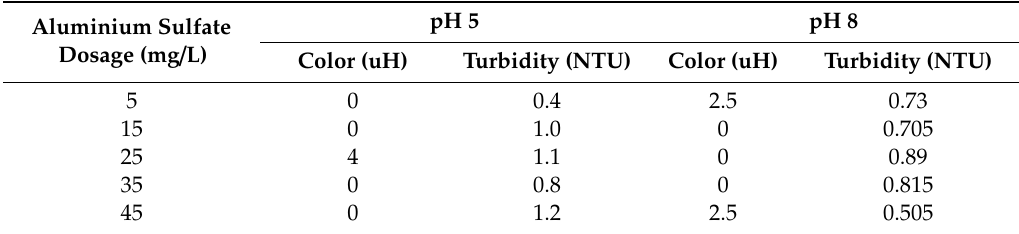
Table 8. Remaining apparent color and turbidity after decantation and filtration of Type III water sample. Aluminium Sulfate